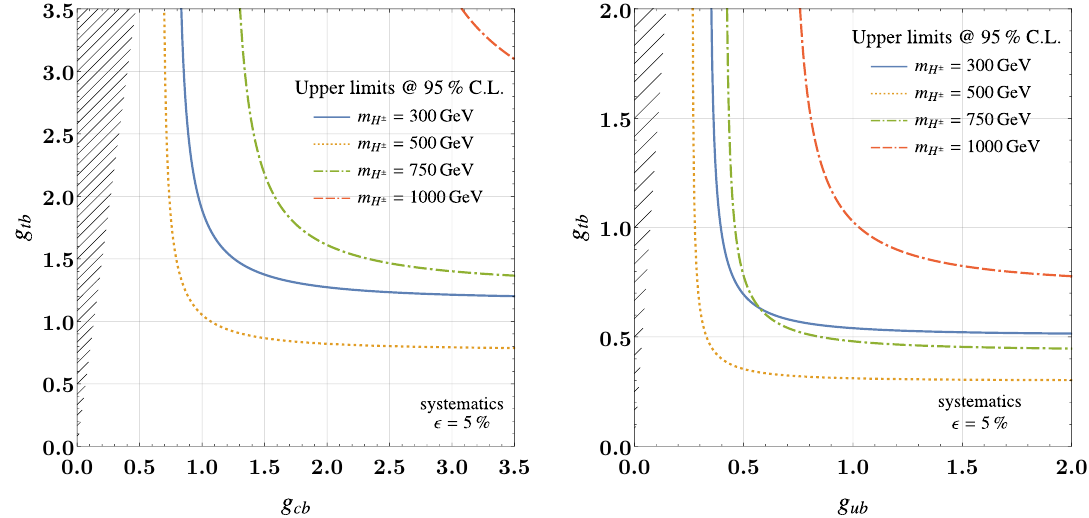
Figure 8 . Expected 95% CL upper limits in the plane of charged Higgs couplings g tb – g cb (left panel) and g – g (right panel) for different charged-Higgs masses and tb ub When the ratio of g ( g ) becomes so large that charged Higgs production is no longer tb /g cb tb /g ub dominated by ug ( cg ) fusion, the bounds from the proposed analysis loose their validity. We indicate this region, roughly defined when associated production with top quarks makes up more than 10% of total charged Higgs production, with a hatching.